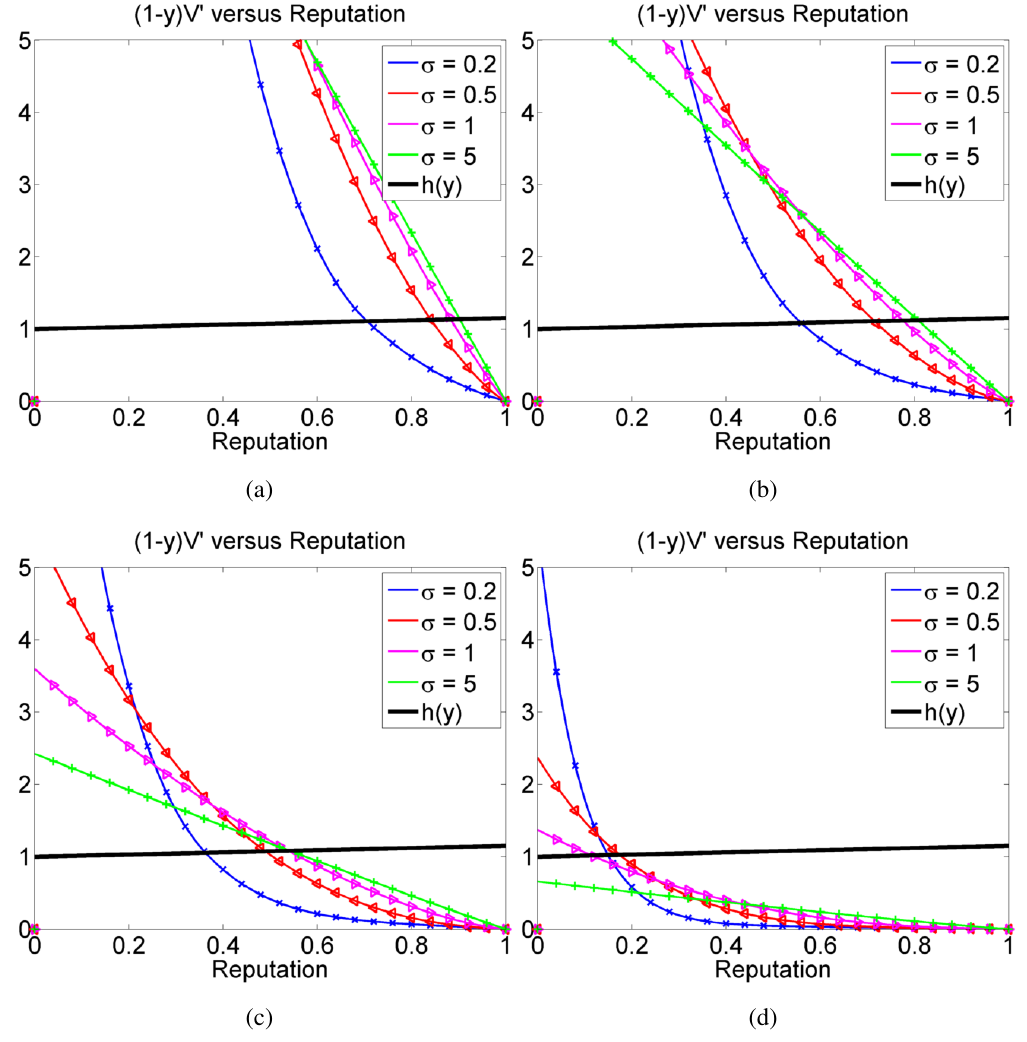
Figure 2. A plot of the quantity (1 − y ) V (cid:48) ( y ) , where V ( y ) is a numerical solution of the the reduced boundary value problem Equation (17). The value y ∗ is defined as the intersection of these curves with h ( y ) (the solid line). ( a ) ρ = 0 . 1 ; ( b ) ρ = 0 . 2 ; ( c ) ρ = 0 . 5 ; ( d ) ρ = 2 . 0